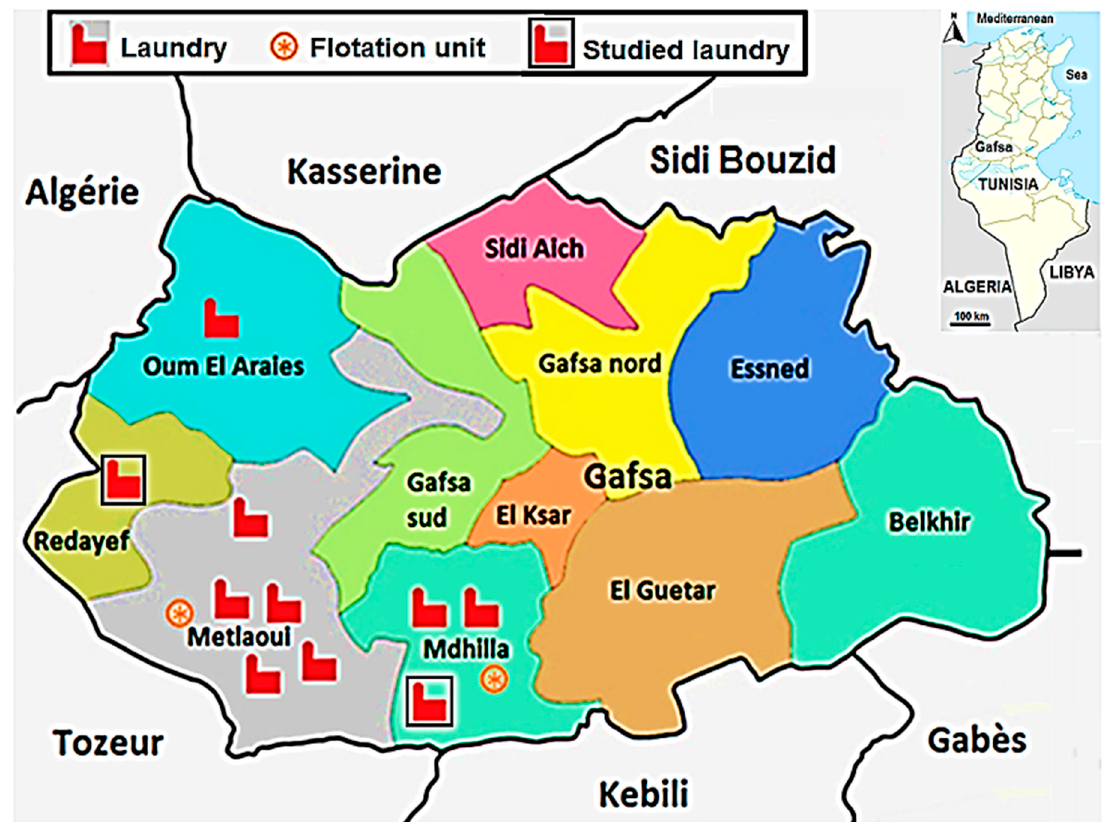
Figure 1. Location map of phosphate laundries in the Gafsa-Metlaoui Basin.